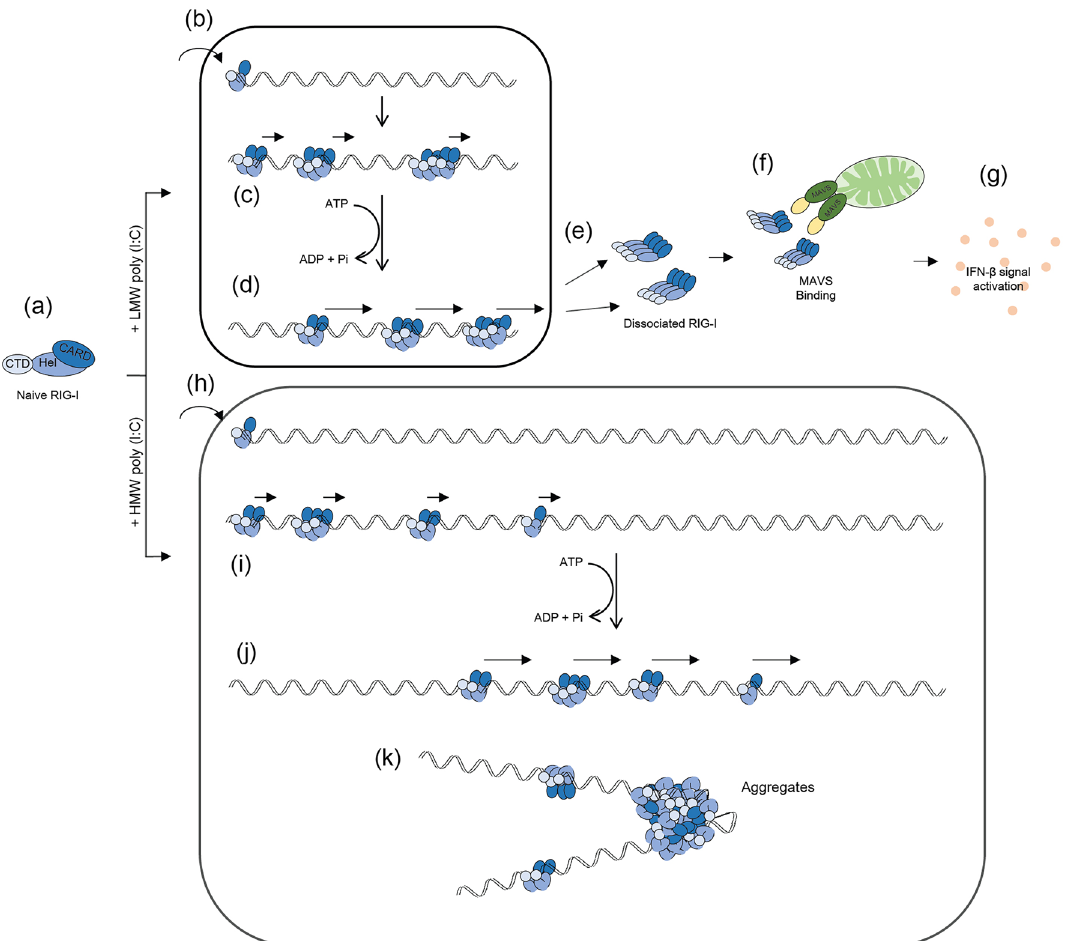
Figure 6. Model for dsRNA length-dependent activation of RIG-I. ( a ) Naïve RIG-I mostly retains closed monomeric conformation where CARD is masked. CARD: caspase activation and recruitment domain, Hel: helicase domain, CTD: C-terminal domain. ( b ) RIG-I recognizes termini of short dsRNA and initiates binding. ( c ) RIG-I translocates along the length of short dsRNA and initiates oligomer formation. ( d ) RIG-I hydrolyzes ATP, accelerating RIG-I translocation on dsRNA and resulting in dissociation from termini. ( e ) The dissociated RIG-I from short dsRNA maintains its oligomeric form. ( f ) Dissociated RIG-I binds to MAVS on mitochondria, resulting in MAVS oligomerization and recruitment of downstream signaling molecules. ( g ) Oligomerization of MAVS induces IFN-β signals by activation of downstream signals, including TBK1 and IRF3. ( h ) RIG-I recognizes termini of long dsRNA and initiates binding with slower kinetics because of limited number of termini. ( i ) RIG-I translocates along the length of long dsRNA. ( j ) RIG-I hydrolyses ATP, accelerating RIG-I translocation on dsRNA. Because of long distance to travel, little RIG-I dissociation takes place. ( k ) In addition, during translocation on long dsRNA, RIG-I forms irregular aggregates that block its translocation and